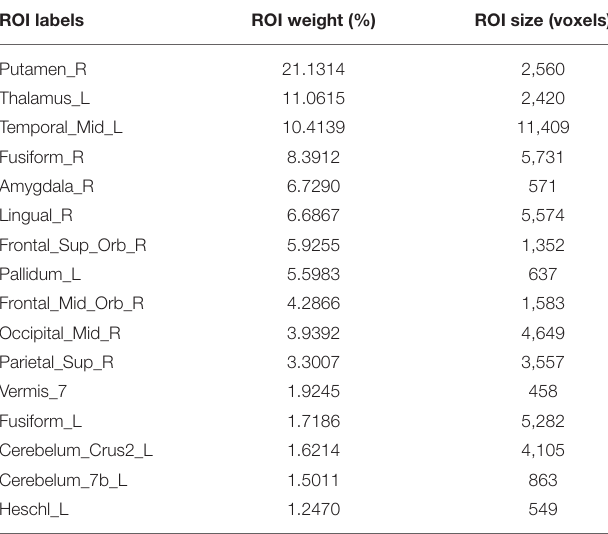
ROIlabelsarederivedfromtheAALatlas.Pleasenotethatonlyregionswhosecontribution exceeded the 1% are displayed.